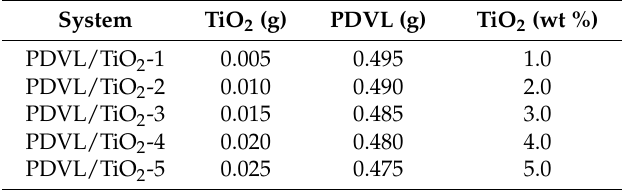
Table 1. Preparation conditions of poly( δ -valerolactone) (PDVL)/TiO 2 nanocomposites.